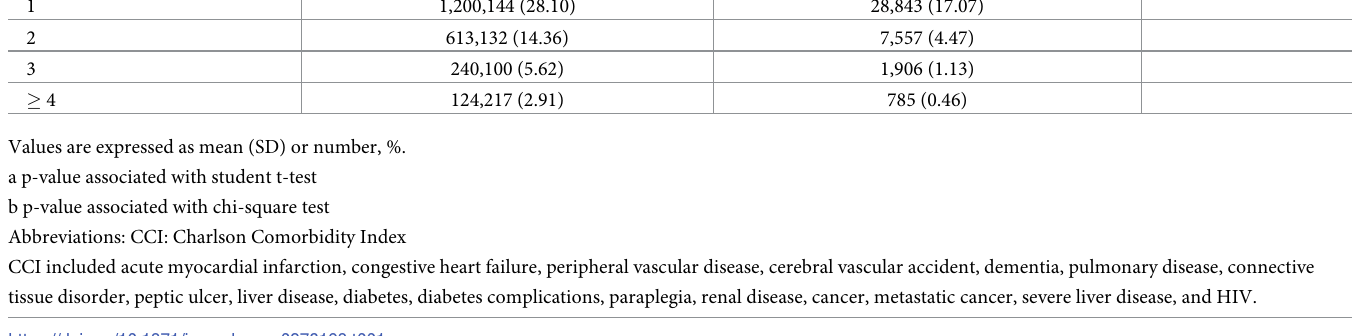
Table 3 represents the odds of adverse pregnancy outcomes by maternal ethnicity. The odds of GDM, preeclampsia, CS, placental abruption, placental previa, PPH, PH, and UAE was lower in foreign women than Korean women. However, after adjustment for age, parity,